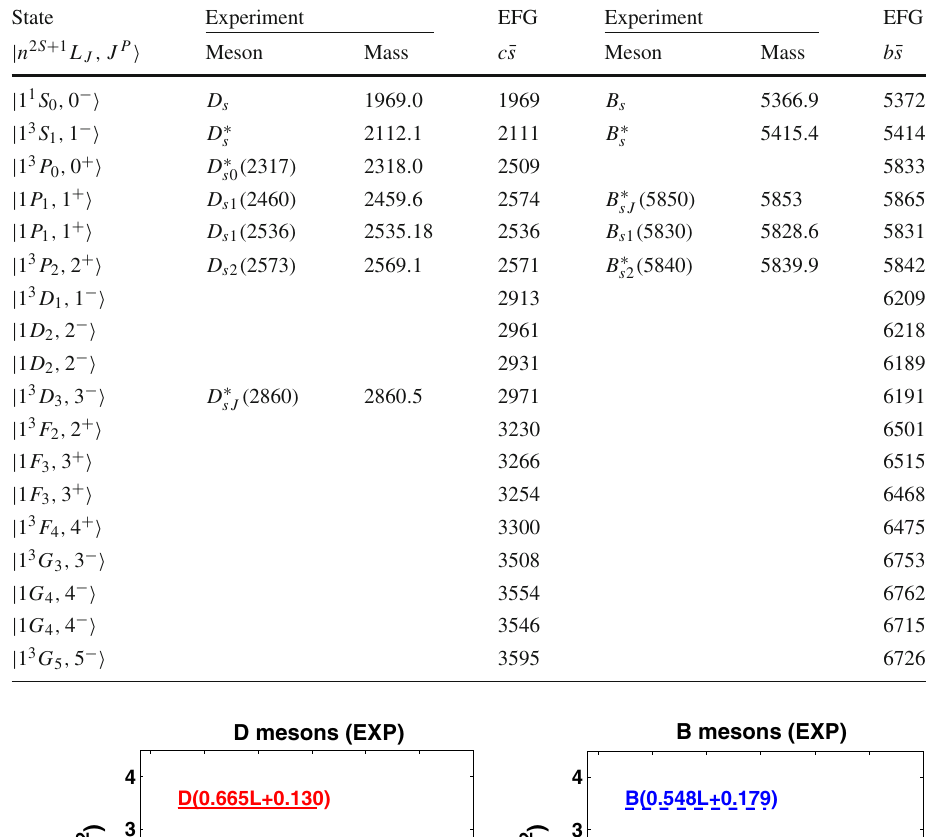
Fig. 2 Plots of experimental data for D and B mesons in L vs. ( M − m c , b ) 2 . The best fit lines are given with equations